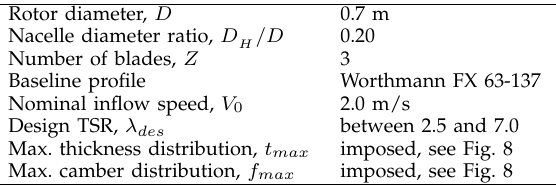
TABLE II M ODEL TURBINE DESIGN CONDITIONS .